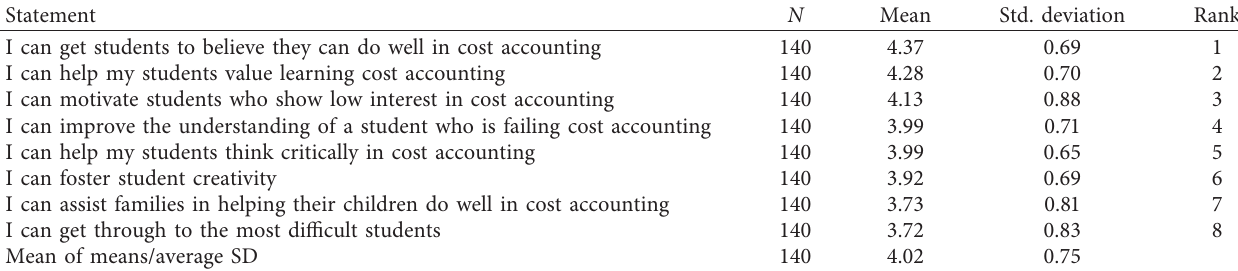
Table 3: Preservice accounting teachers’ self-efficacy in student engagement in teaching cost